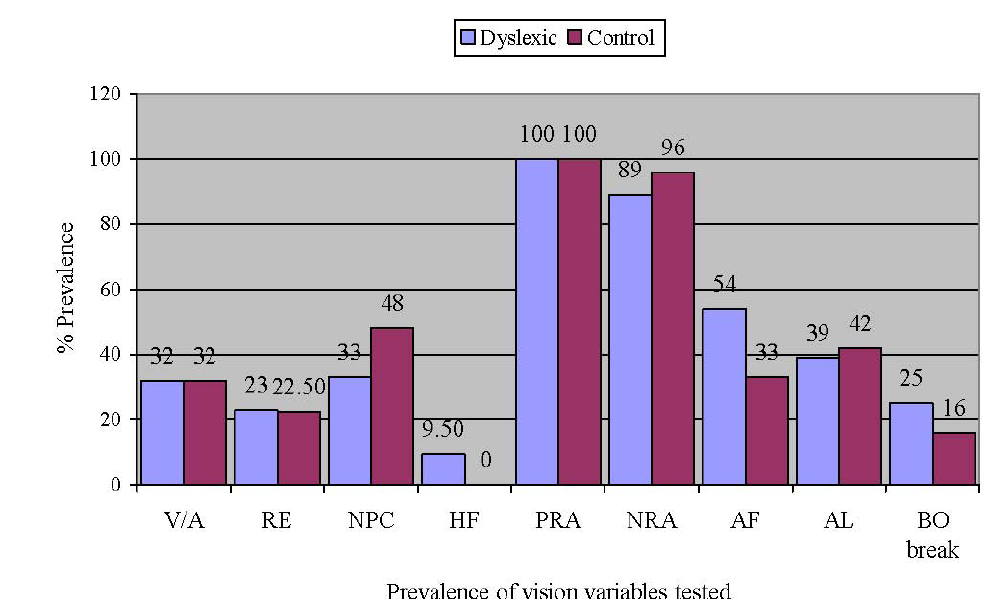
Figure 3. Comparison of the percentage prevalence of all the vision variables examined between the dyslexic and control groups as defined in Table 1. VA=visual acuity, RE=refractive errors, HF=heterophoria, NPC=near point of convergence, PRA=positive rela - tive accommodation, NRA=negative relative accommodation, AF=accommodative facility, AL=accommodative lag, BO break = base out to break at near. The prevalence of remote NPC (> 10 cm) was significantly higher in the control group than in the dyslexic group whereas the prevalence of poor accommodative facility was significantly higher in the dyslexic than in the control